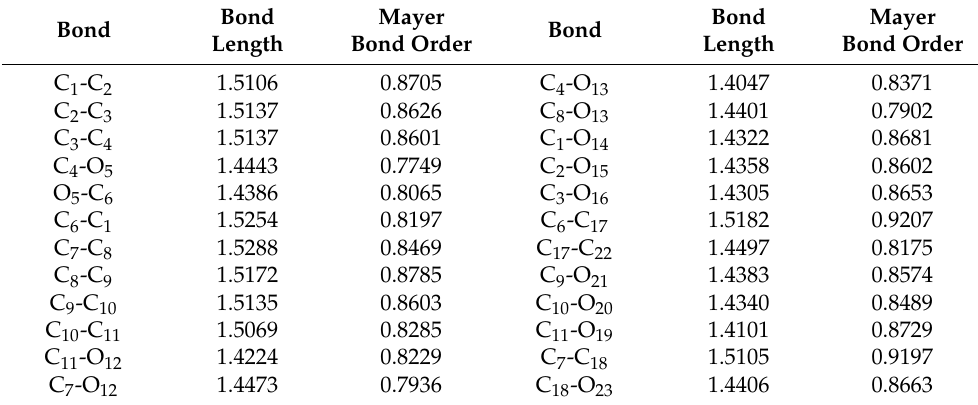
Table 1. Bond length and Mayer bond order of